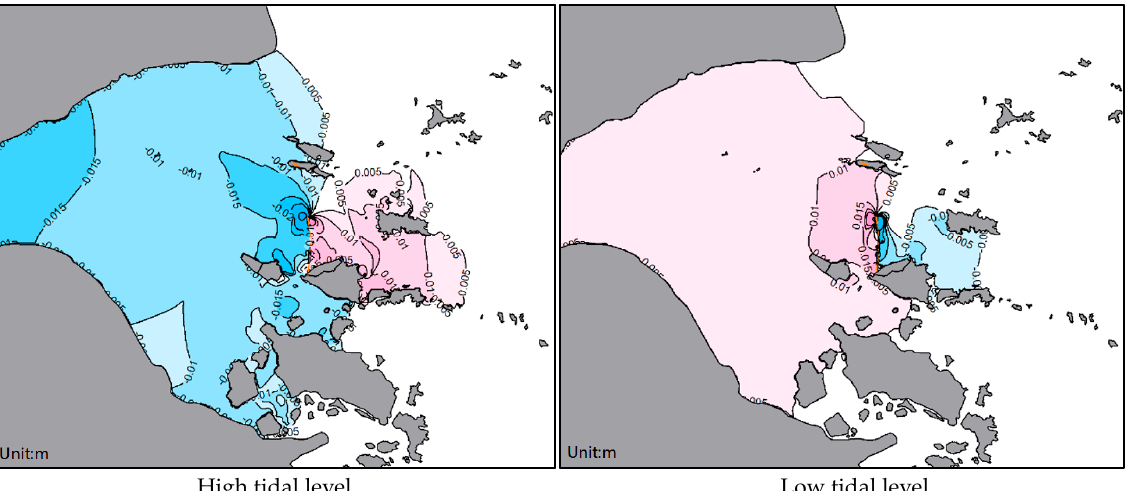
Figure 8. High and low tide level changes (the positive value is the increase in tidal level, and the negative value is the decrease in tidal level).